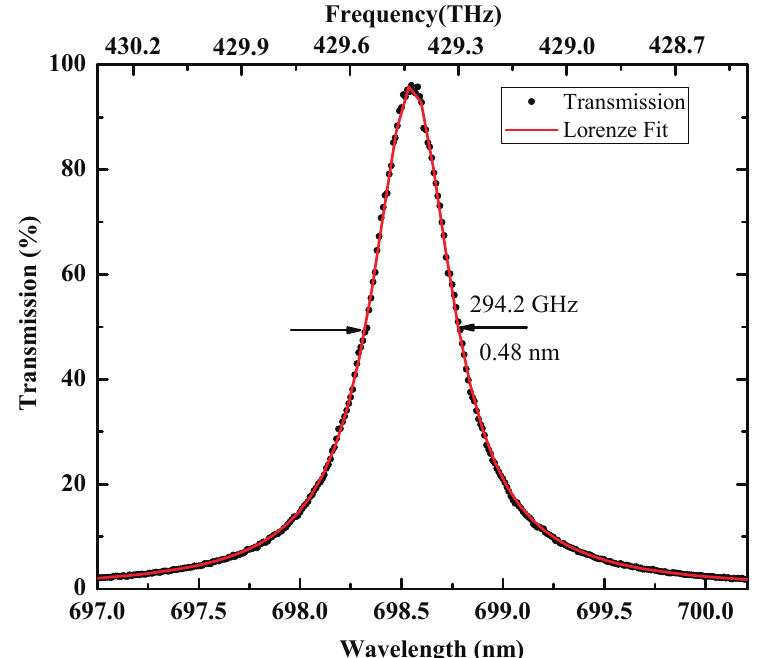
Figure 2. Measured transmission spectrum of interference filter (IF) with 6 ◦ angle of incidence. Data provided by manufacturer (Alluxa, Santa Rosa, CA, USA). The IF has a peak transmittance of up to 96% and a bandwidth of ∼ 0.48 nm(294.2